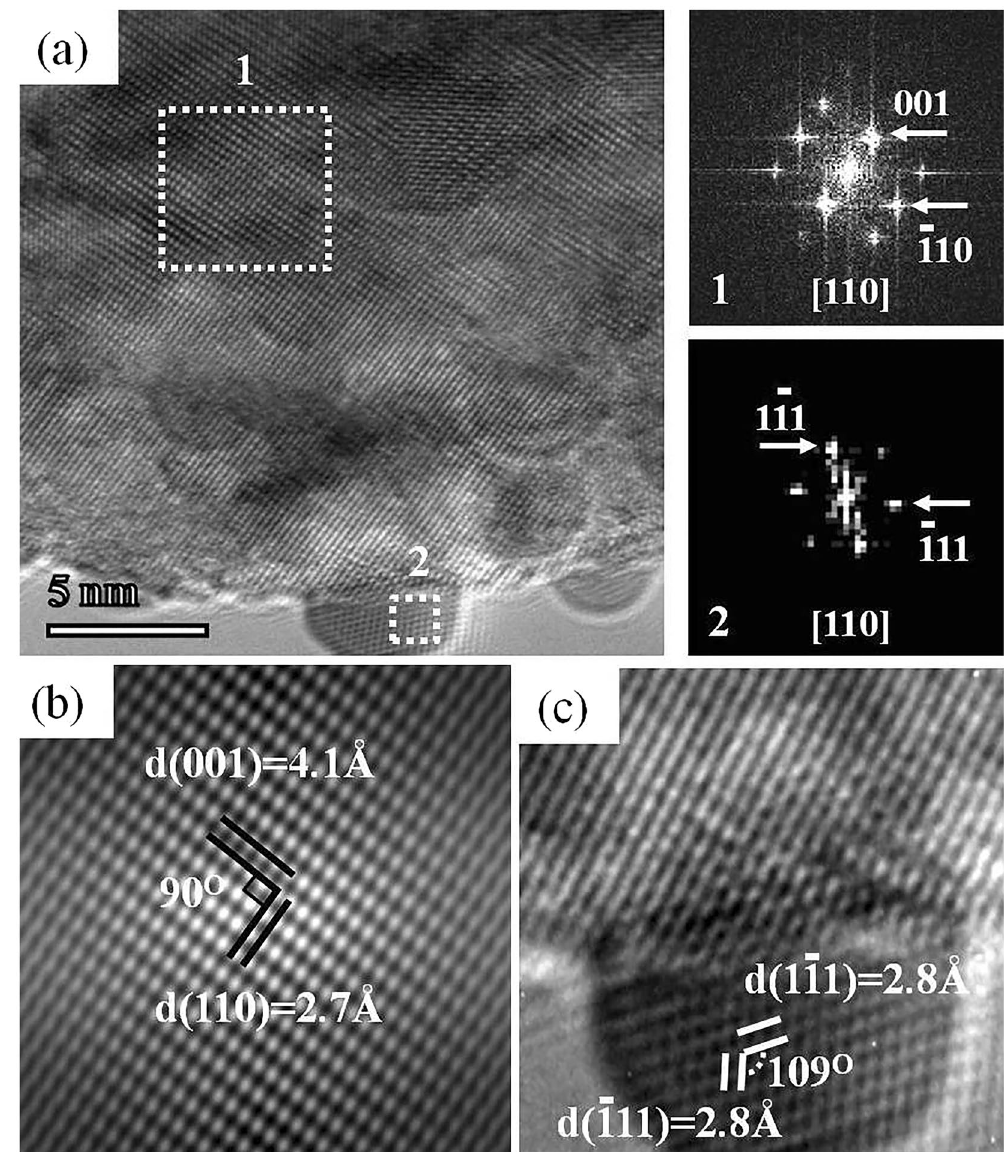
Figure 3. ( a ) TEM image of Pb-PTO nanomaterial. The right side image 1 and 2 are corresponding FFT patterns of PTO and Pb respectively, the selected area shown in Fig ( a ) by dotted rectangles. ( b ) FFT filtered image of the selected area as denoted 1 in Fig ( a ). ( c ) FFT filtered image of the selected area around Pb